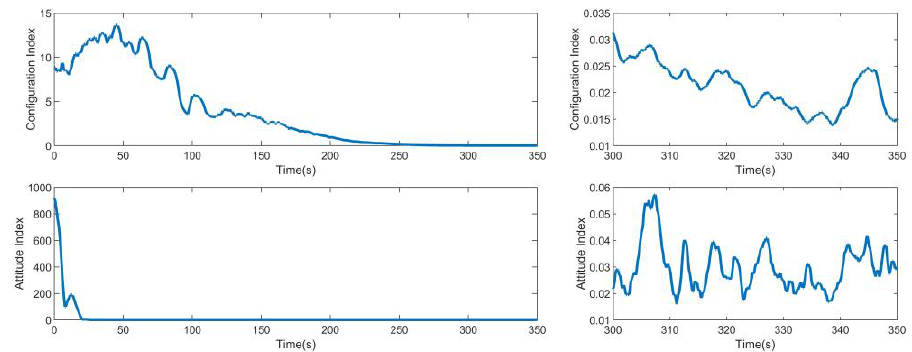
Figure 15. Configuration maintenance index and relative attitude index of non-consistent collabo- rative control for SAR satellite formation.